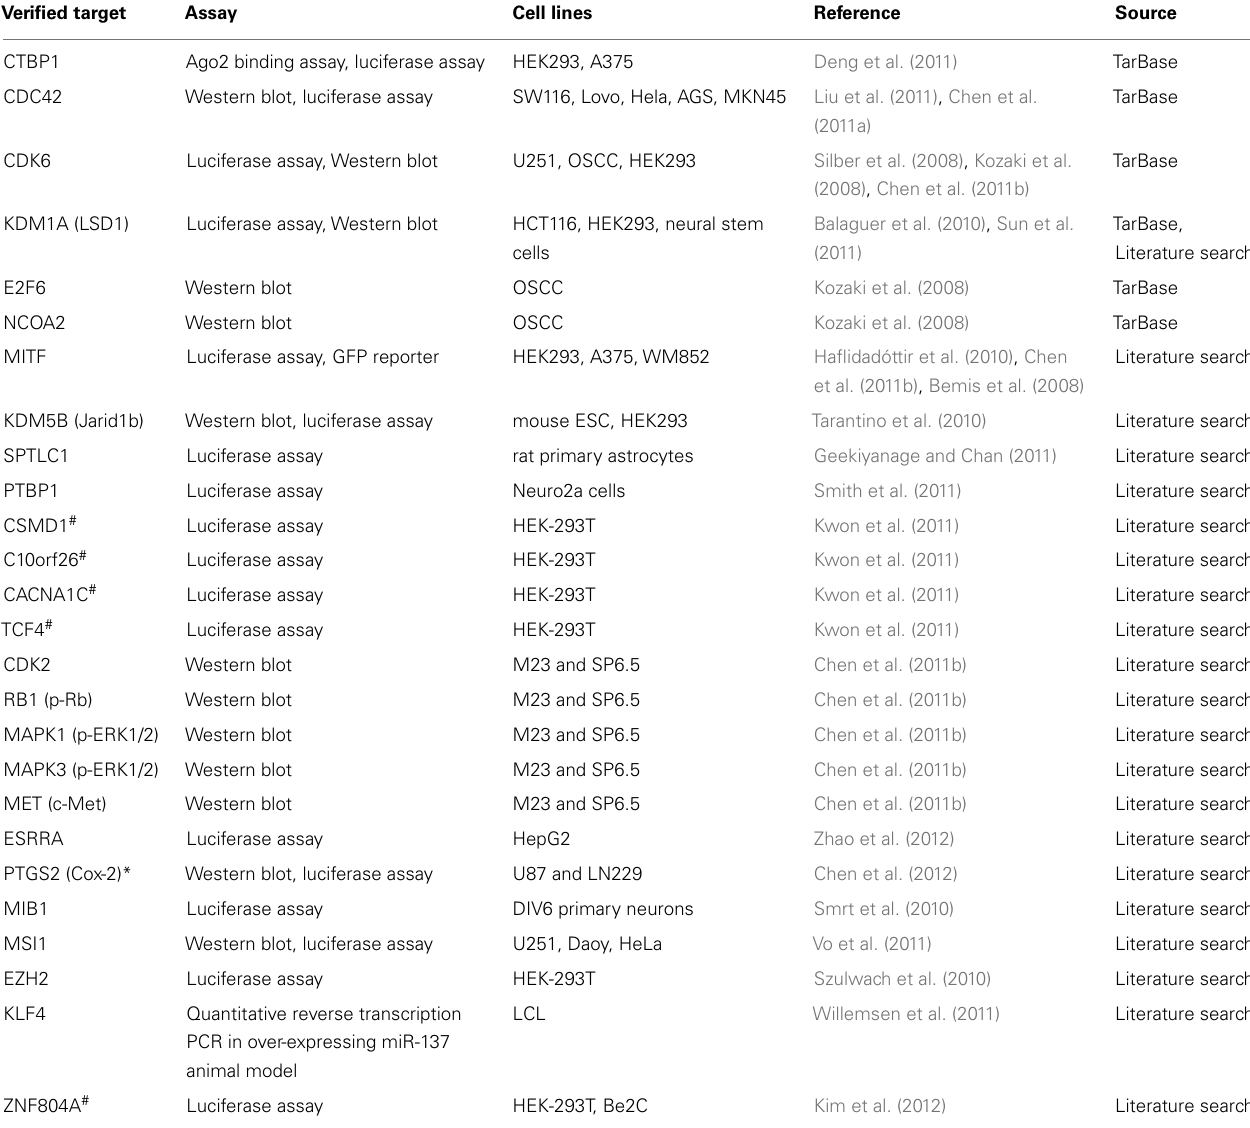
Table 2 | Experimentally verified targets of